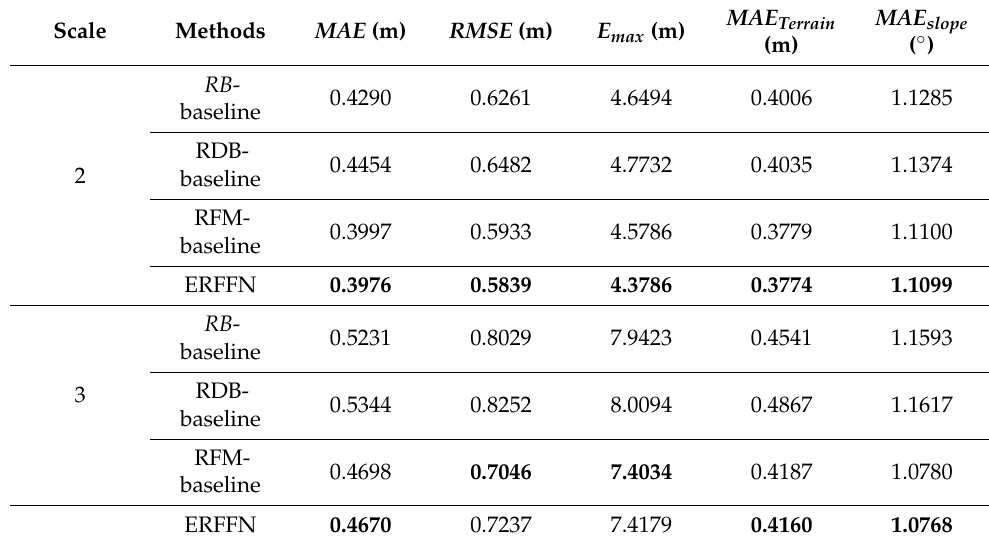
Table 4. Comparison of the performance of different residual blocks for various reconstruction scales.